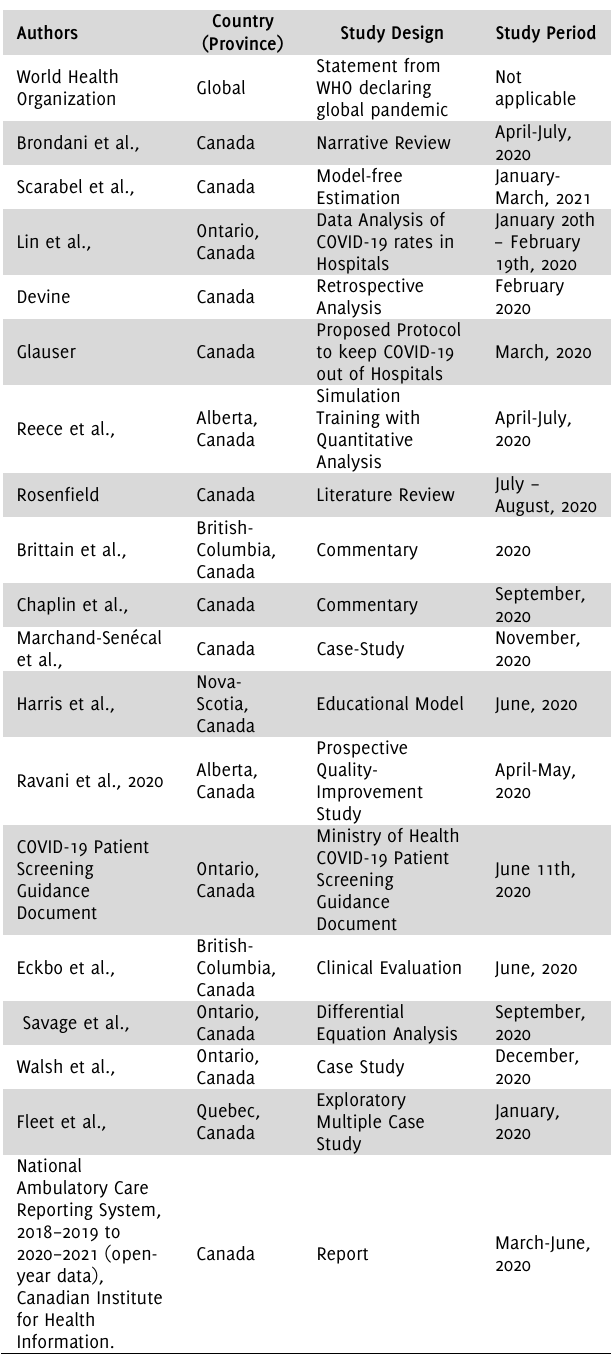
Table 1 . Summary of articles included in the narrative